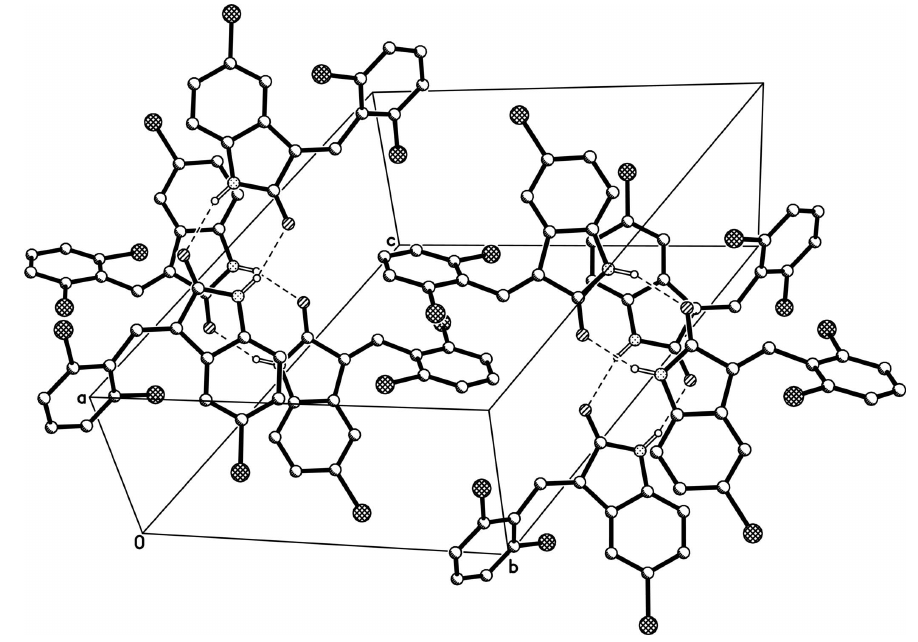
Figure 2 A unit cell packing view of the title compound. Dash lines indicate hydrogen bonds. For clarity, H atoms not involved in H-bonding were